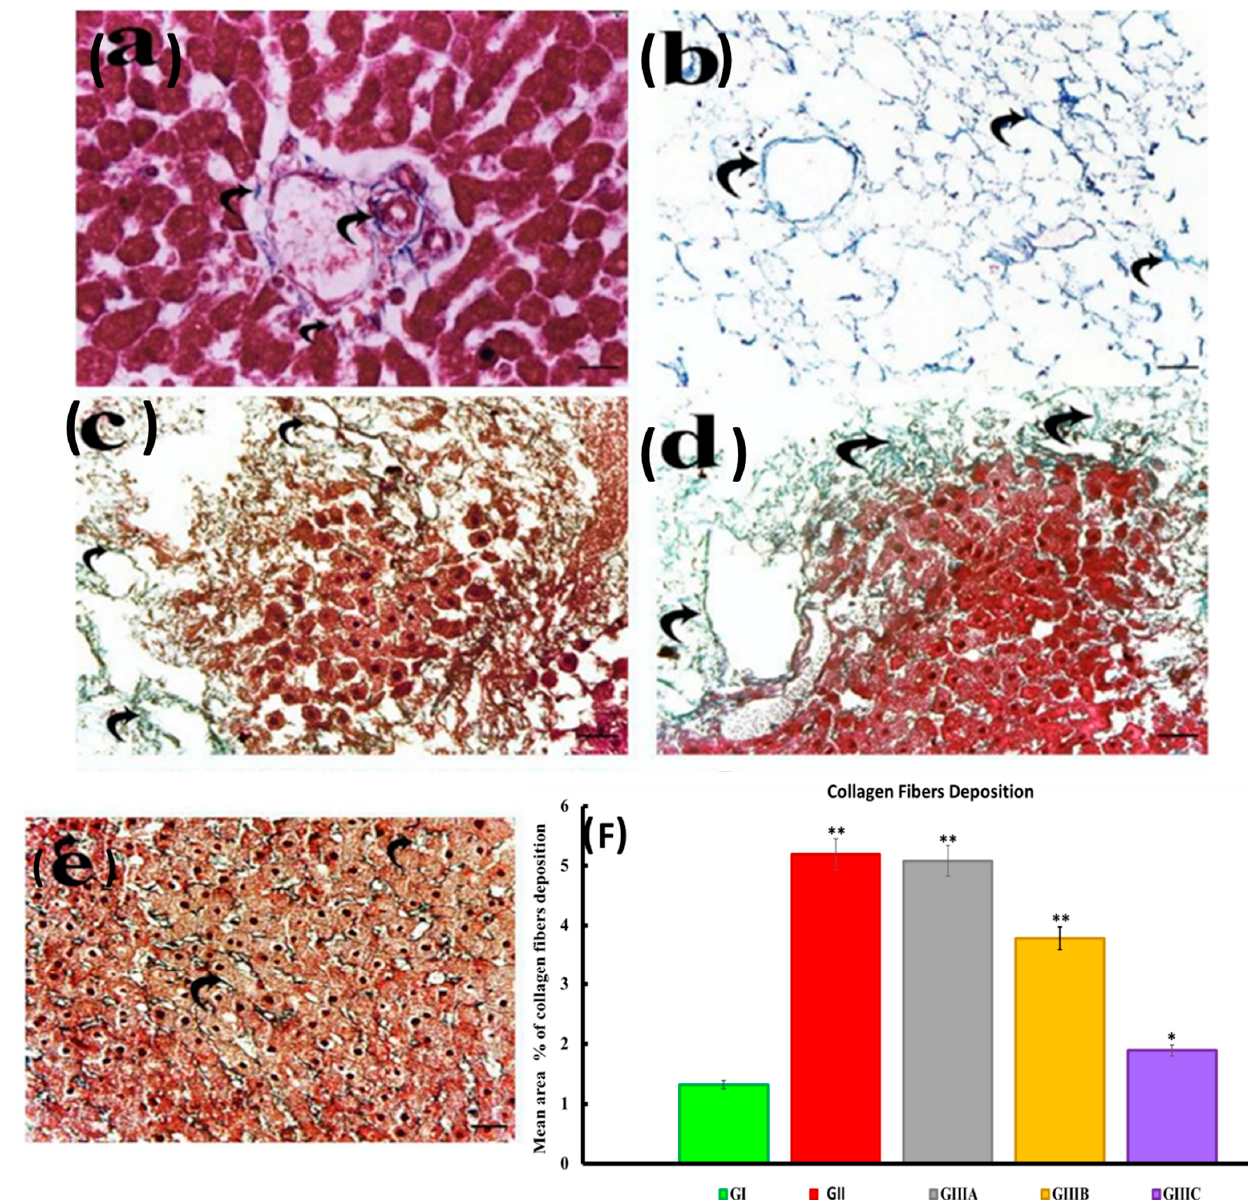
Figure 6. A photomicrograph of Masson’s trichrome stained sections in normal liver, decellularized scaffolds as well as recellularized scaffold 4, 14 and 24 days after iPS cell seeding showed ( a ): group I (control group) showed minimal collagen fibers accumulation (curved arrow) around portal tract; ( b ): group II (decellularized group) showed preserved collagen fibers (curved arrow) as well as the portal and lobular connective tissue structure in decellularized liver scaffolds; ( c ): group IIIa (recellularized group after 4 days) showed marked collagen fibers (curved arrow) with minimal amount of cell colony (*); ( d ): group IIIb (recellularized group after 14 days) showed moderate collagen fibers (curved arrow) with moderate amount of cell colony (*); ( e ): group IIIc (recellularized group after 24 days) showed minimal collagen fibers (curved arrow) with extensive amount of cell colony forming sheets of hepatocytes (*); ( f ): A histogram represents the mean area percentage of collagen in all experimental groups. The significant differences against the control group indicated by a * for p < 0.05 and a ** for p < 0.01. Data are shown as mean ± S.E.M, n =